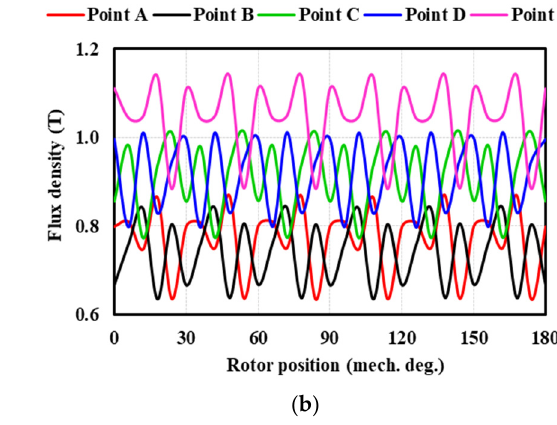
Figure 10. Demagnetization analysis: ( a ) Observed points; ( b ) Flux density variation of observed points at 105 °C.